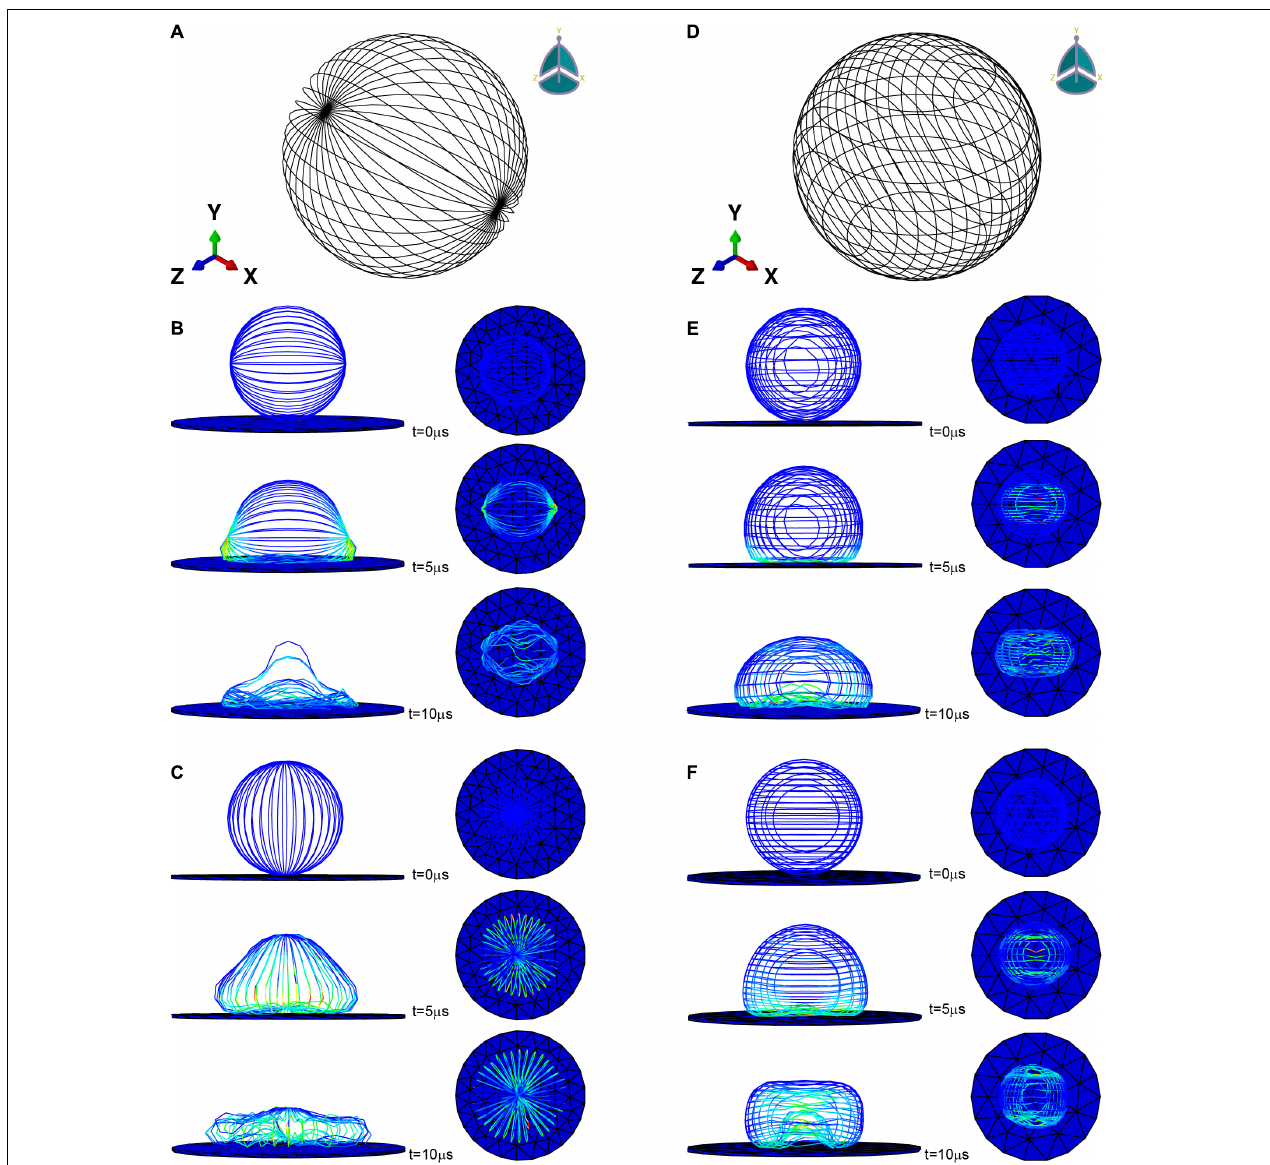
FIGURE 2 | Microfilament network model of (A) L929 and (D) HC11. (B,C) are the adherence process when the microfilament network model of L929 is subjected to gravity toward the Y axis and toward the X axis, respectively. (E,F) are the adherence process when the microfilament network model of HC11 is subjected to gravity toward the Y axis and toward the Z axis,